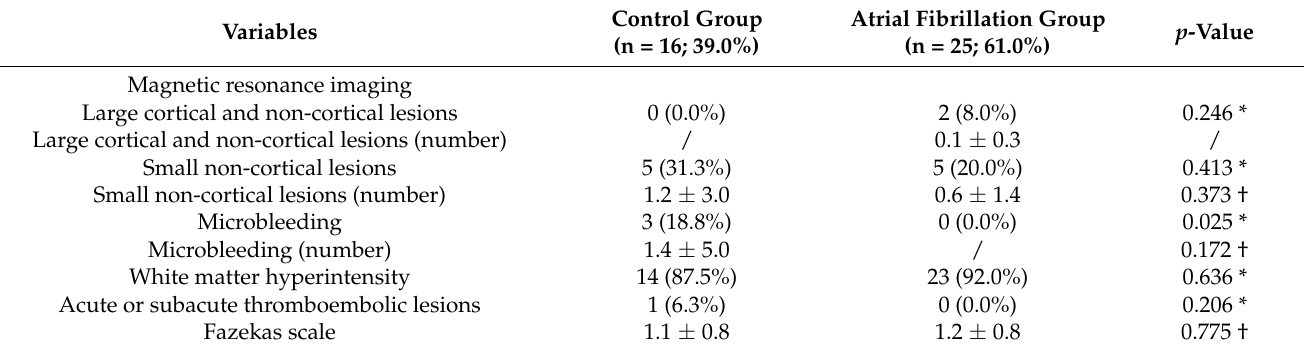
Table 2. Comparison of cerebrovascular findings on magnetic resonance imaging between the study groups.